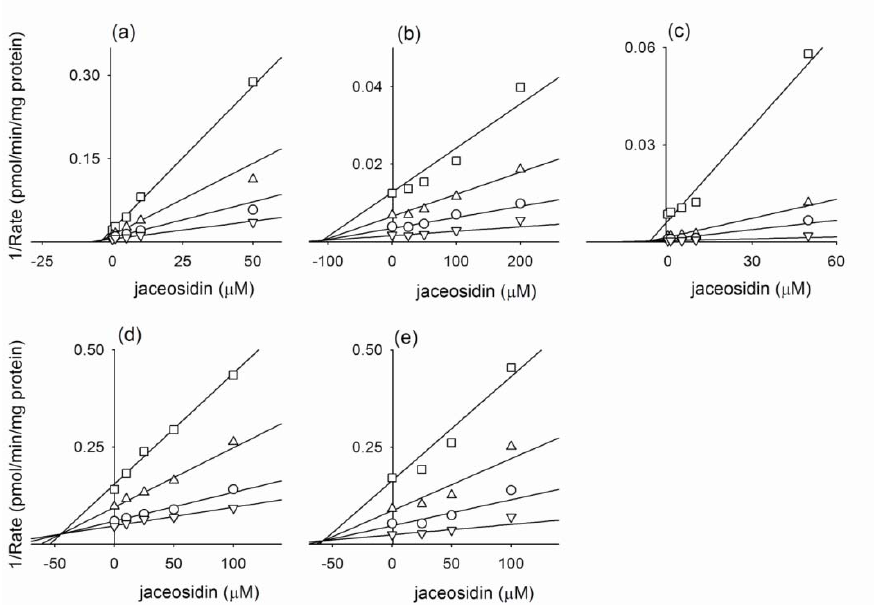
Figure 2. Representative Dixon plots for inhibitory effects of jaceosidin on (a) CYP1A2- catalyzed phenacetin O -deethylation, (b) CYP2C8-catalyzed amodiaquine N -deethylation, (c) CYP2C9-catalyzed diclofenac 4-hydroxylation, (d) CYP2C19-catalyzed [ S ]- mephenytoin 4 ′ -hydroxylation, and (e) CYP2D6-catalyzed bufuralol 1 ′ -hydroxylation in pooled human liver microsomes. Each symbol represents the substrate concentration. (a) phenacetin: 10 μ M ( ▽ ), 20 μ M ( ○ ), 40 μ M ( △ ), and 80 μ M ( □ ); (b) amodiaquine: 0.5 μ M ( ▽ ), 1.0 μ M ( ○ ), 2.0 μ M ( △ ), and 5.0 μ M ( □ ); (c) diclofenac: 1 μ M ( ▽ ), 5 μ